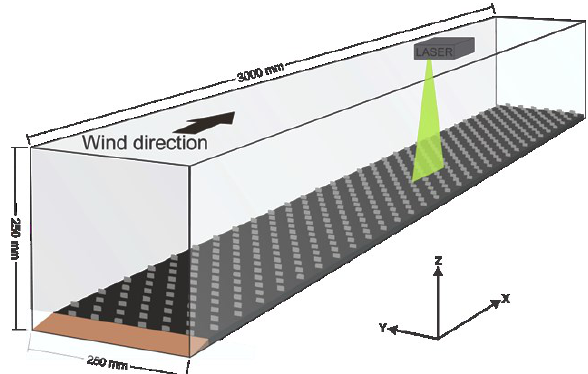
Fig. 1. Wind tunnel with roughness elements (setup M4) and position of the laser sheet